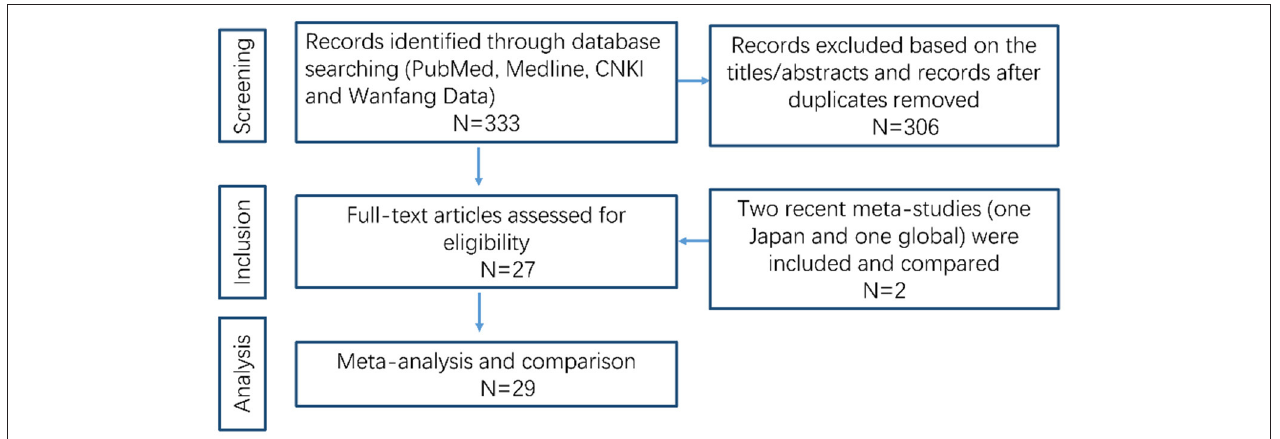
FIGURE 1 | Flow diagram of data search and